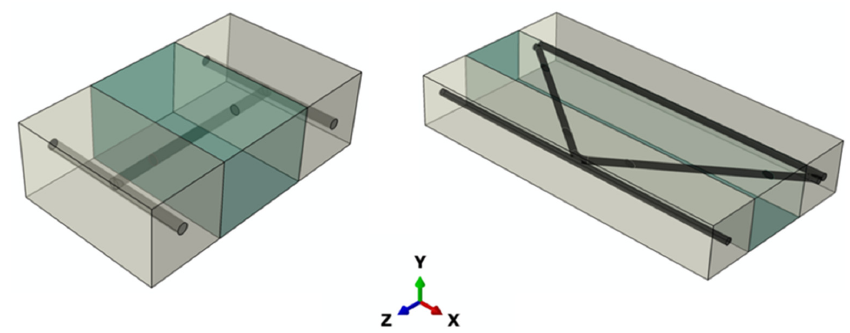
Figure 4. Isometric view of two unit cells for reinforced 3DPC wall.